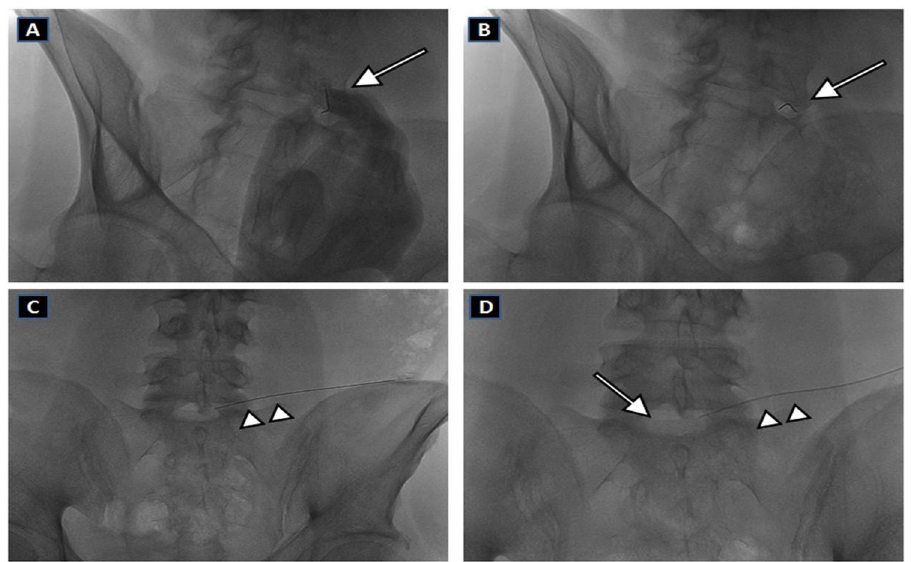
Fig 1. Fluoroscopy-guided intradiscal ozone therapy of right-sided L5-S1 disc herniation. Prone decubitus. (A, B) Oblique fluoroscopic images showing the Chiba needle (arrow) during insertion and advancement. (C) Antero- posterior fluoroscopic view, obtained before oxygen-ozone (O2-O3) mixture injection, showing the needle (arrow- head) tip inside the center of the concerned disc space. (D) Antero-posterior fluoroscopic view, obtained after oxygen- ozone (O2-O3) mixture injection, showing the injected gas as a faint opacity within the disc space.